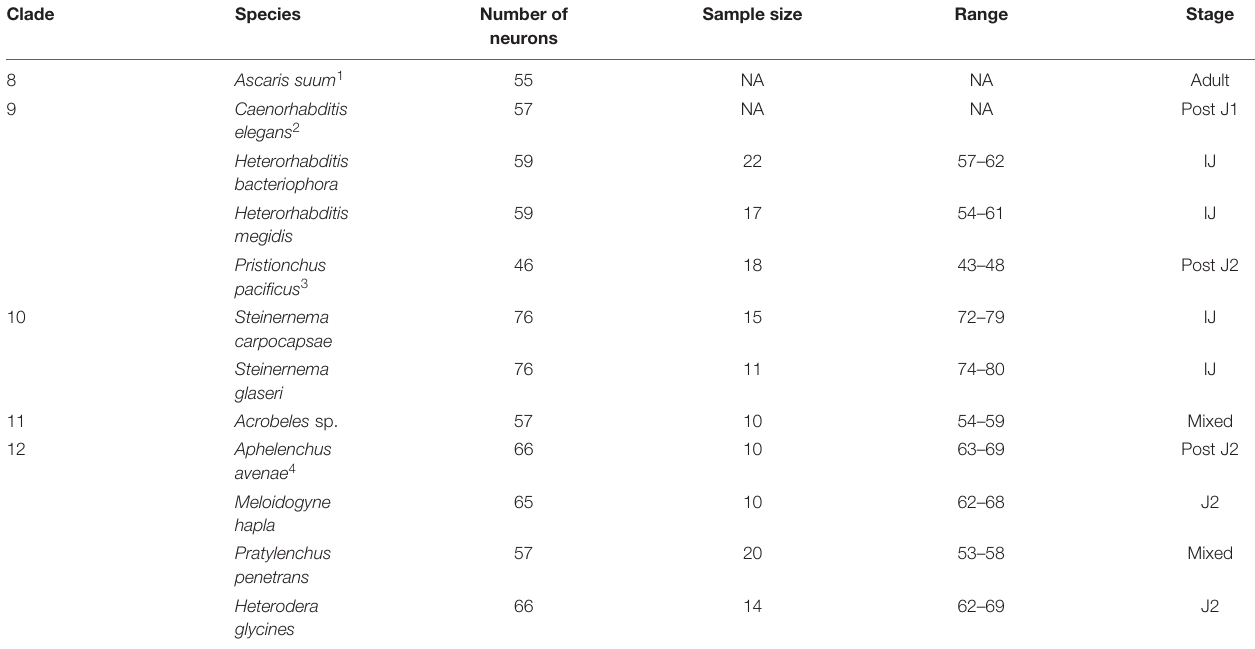
TABLE 1 | Ventral cord neuron cell bodies in nematode